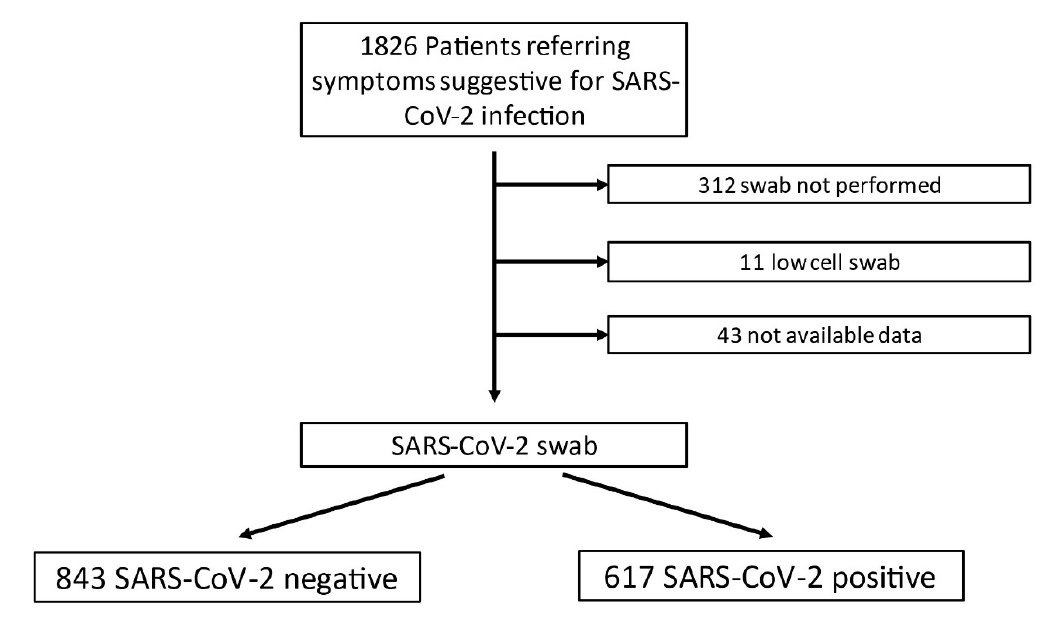
Figure 2. Flowchart scheme with number of patients included and excluded in the study. Table 1. Respiratory and blood gas analytical data found in the emergency department. S/F: SpO 2 /FiO 2 ; P/F: pO 2 /FiO 2 ; ROX index: SpO 2 /FiO 2 to respiratory rate; DELTA (A–a): oxygen alveolar–arterial gradient. Continuous variables are expressed as mean ± standard